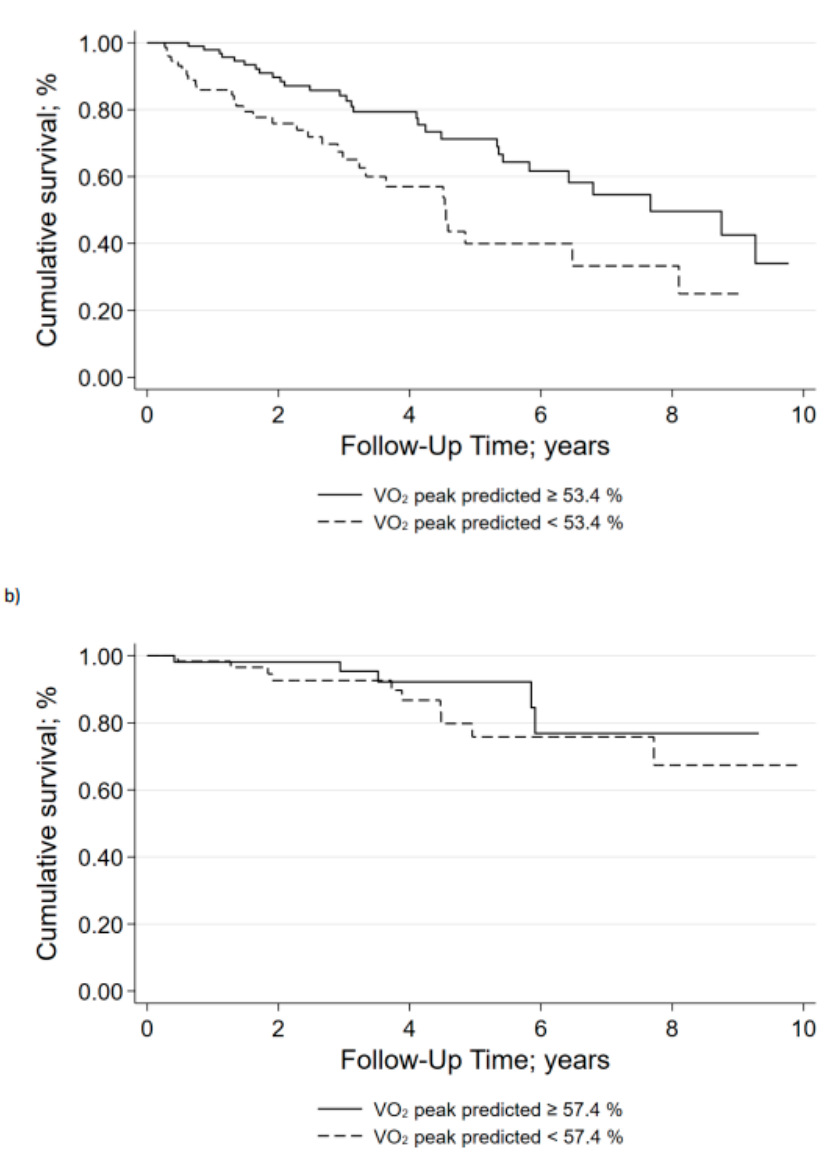
Figure 3. Kaplan-Meier curves for VO2peak (% pred.) in ( a ) the non-surgical group and ( b ) the sur- gical group.—Kaplan–Meier curves of cumulative survival stratified by treatment and VO 2 peak (% predicted). A, Non-surgical group. B, Surgical group. VO 2 peak = peak oxygen uptake.